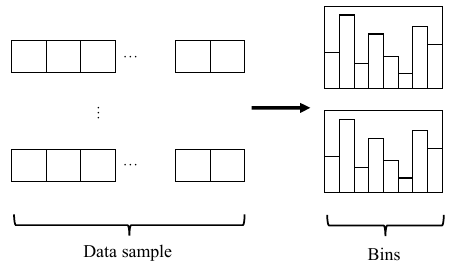
Figure 4. Histogram algorithm.